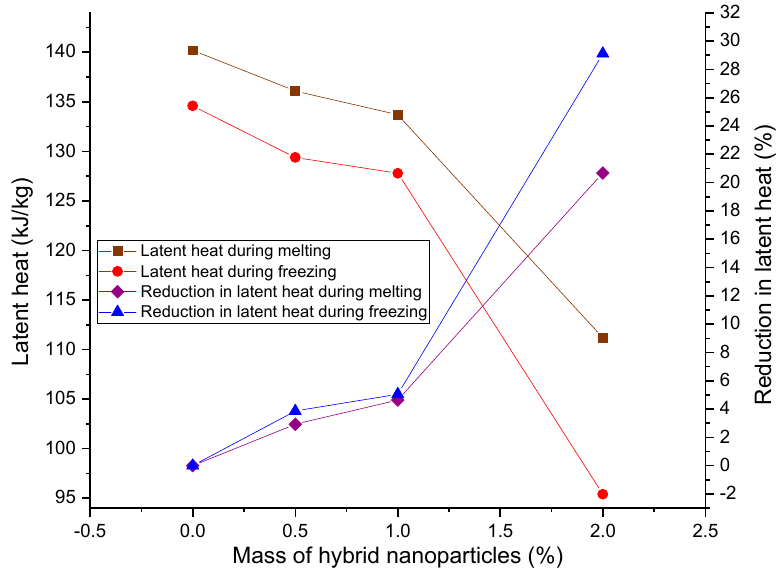
Figure 7. Variation in latent capacity of the hybrid-nano/paraffin samples.